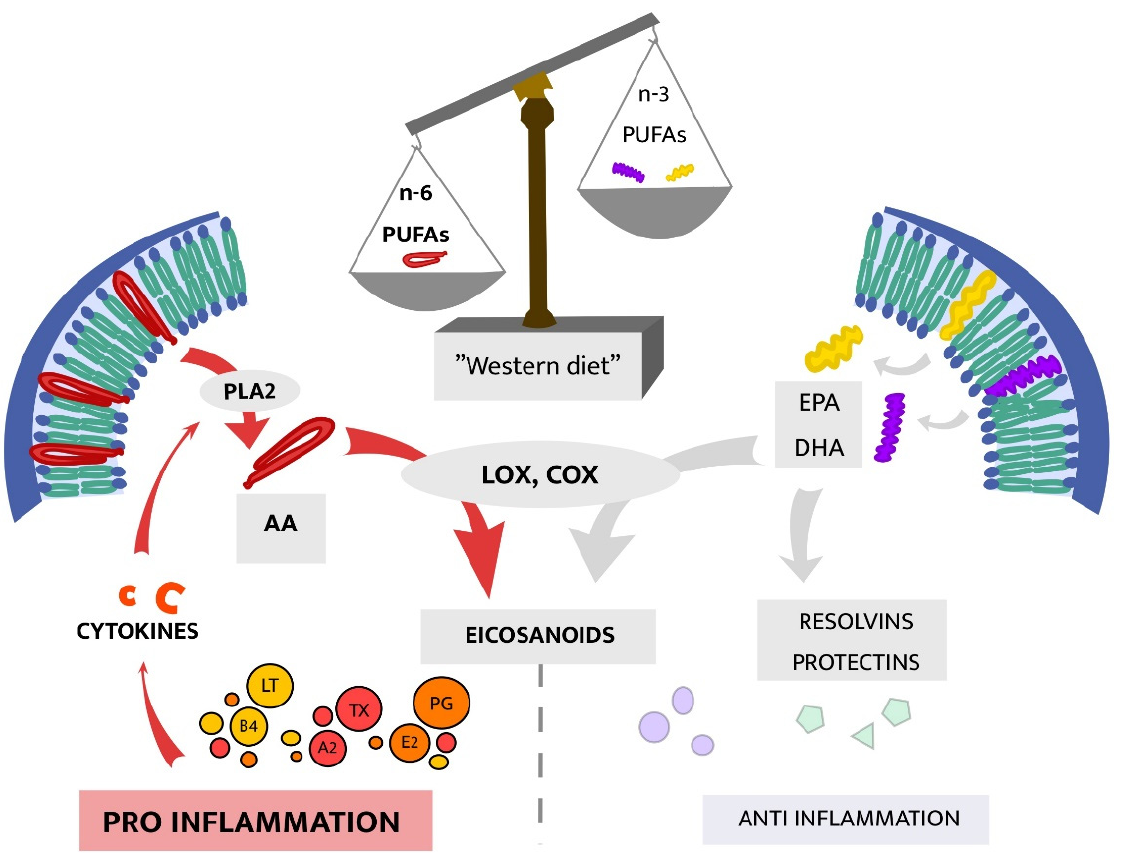
Figure 3. Enzymes LOX and COX are involved in various steps of PUFA metabolization, affecting the pro/anti-inflammatory balance. Abbreviations: omega-6 (n-6), omega-3 (n-3), polyunsaturated fatty acids (PUFAs), eicosapentaenoic acid